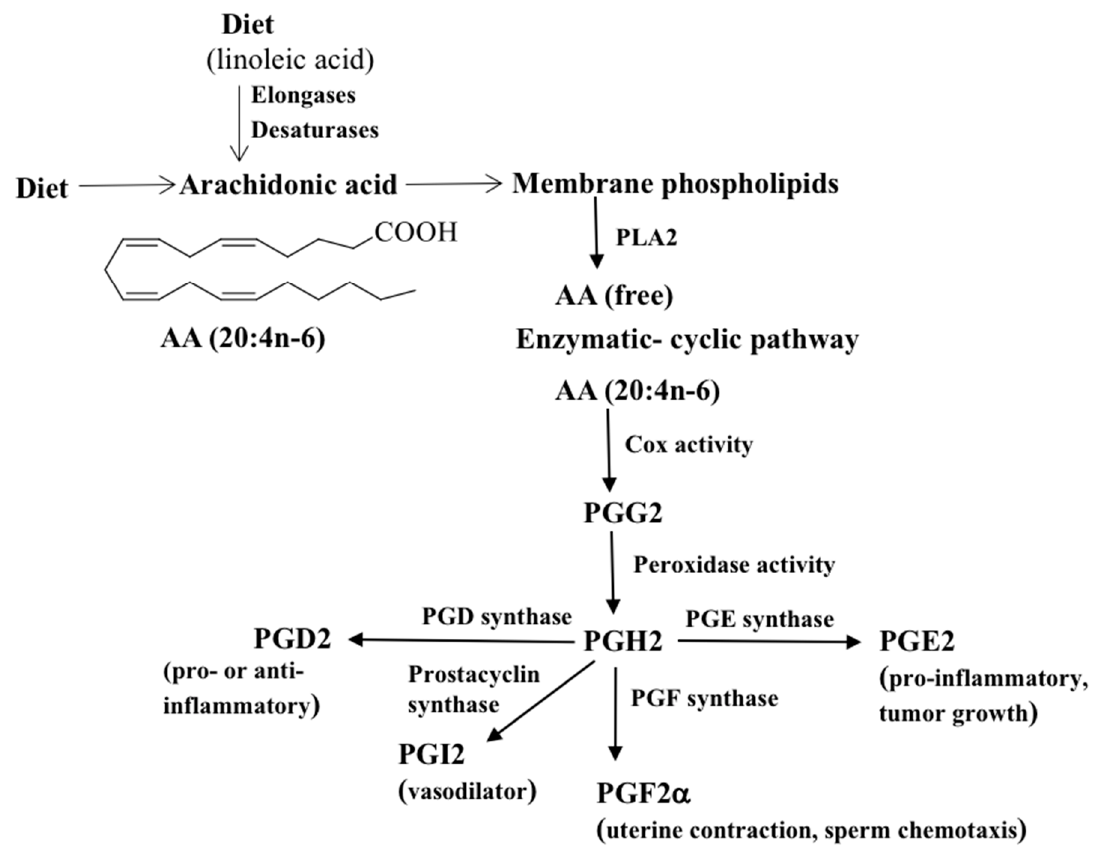
Figure 1. A general overview of the Cox-mediated PG synthesis and their major functions. Mammals, being incapable of synthesizing PUFAs such as linoleic or arachidonic acid, they must be provided in the diet. AA liberated from cellular membrane phospholipids such as phosphatidylocholine by the action of phospholipase A2 (PLA2) is converted to PGH2 via PGG2 by Cox-1/Cox-2 enzymes. PGH2 acts as a substrate for PG synthases to give rise to different PGs.